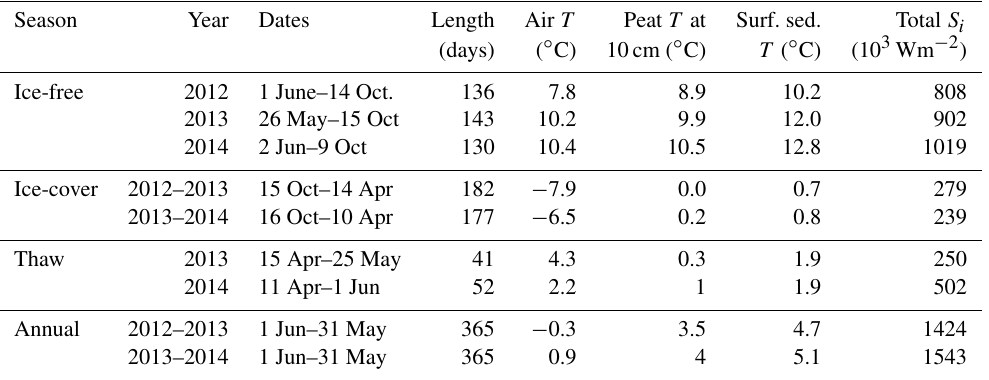
Table 1. Climatic conditions per season: mean air temperature measured at the Abisko Scientific Research Station, peat temperature at 10cm depth in the fen, surface sediment temperature in the lake (1m depth), and total incoming solar radiation ( S i ). Season delimitations (see text for a definition) are reported for each